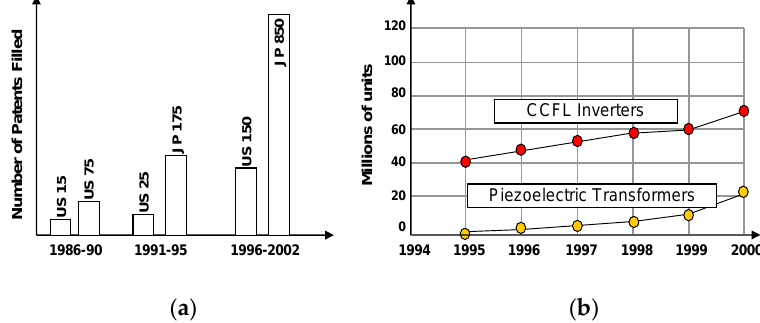
Figure 8. Evolution of PT technology during late 1980s to early 2000s based on author sources. ( a ) Number of filled patents in U.S. and Japan; ( b ) Production of piezoelectric transformers for cold cathode fluorescent lamps (CCFL) applications compared to total CCFL inverter production.